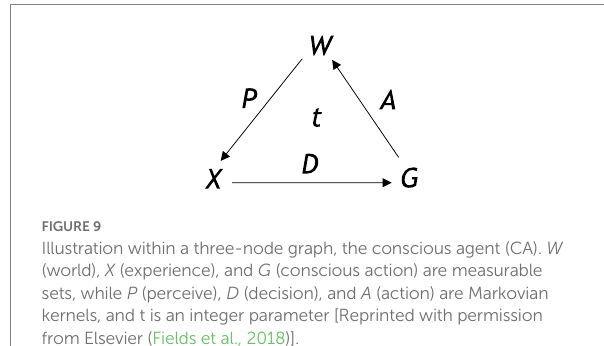
FIGURE 9 Illustration within a three-node graph, the conscious agent (CA).